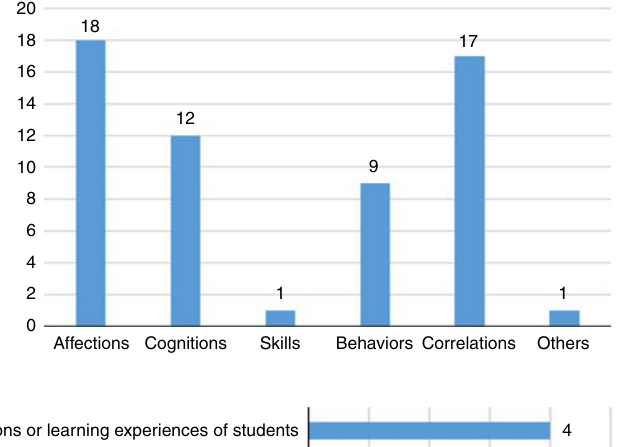
Figure 11. The distribution of the learning outcomes of the e-learning recommender system